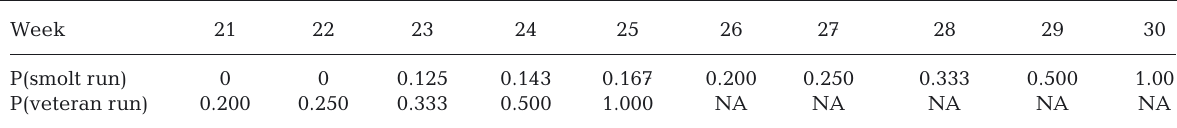
Table 3. Probability (P) of a freshwater resident sea trout migrating to sea as a function of week of the year. NA: the function is not applied in that week (all sea trout have migrated to sea